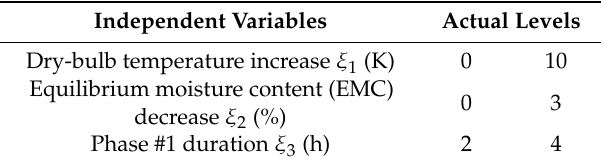
Table 1. Levels of independent variables used for the design of oscillation-drying schedules and processes.